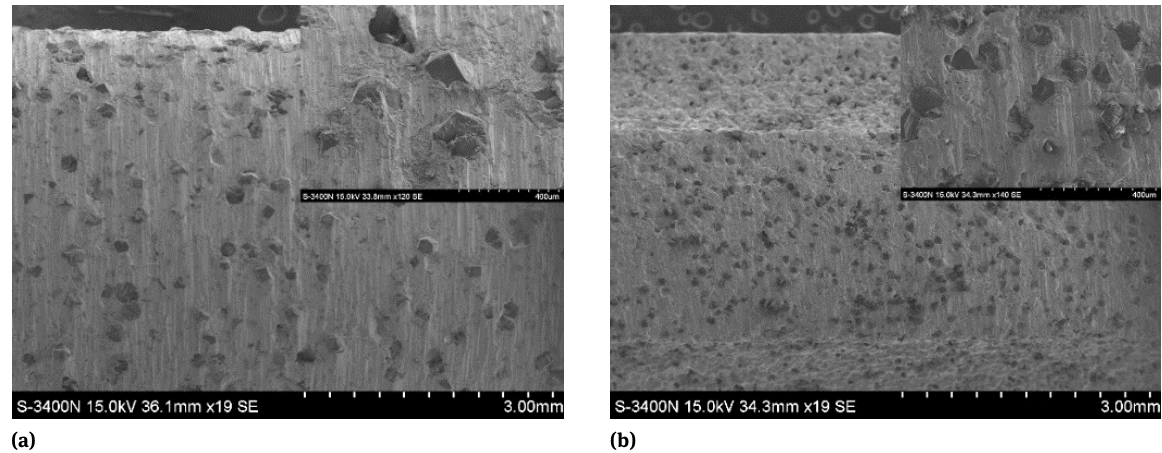
Figure 6: SEM photographs of the abrasive electrode: (a) Abrasive round electrode; (b) Abrasive shaped electrode.